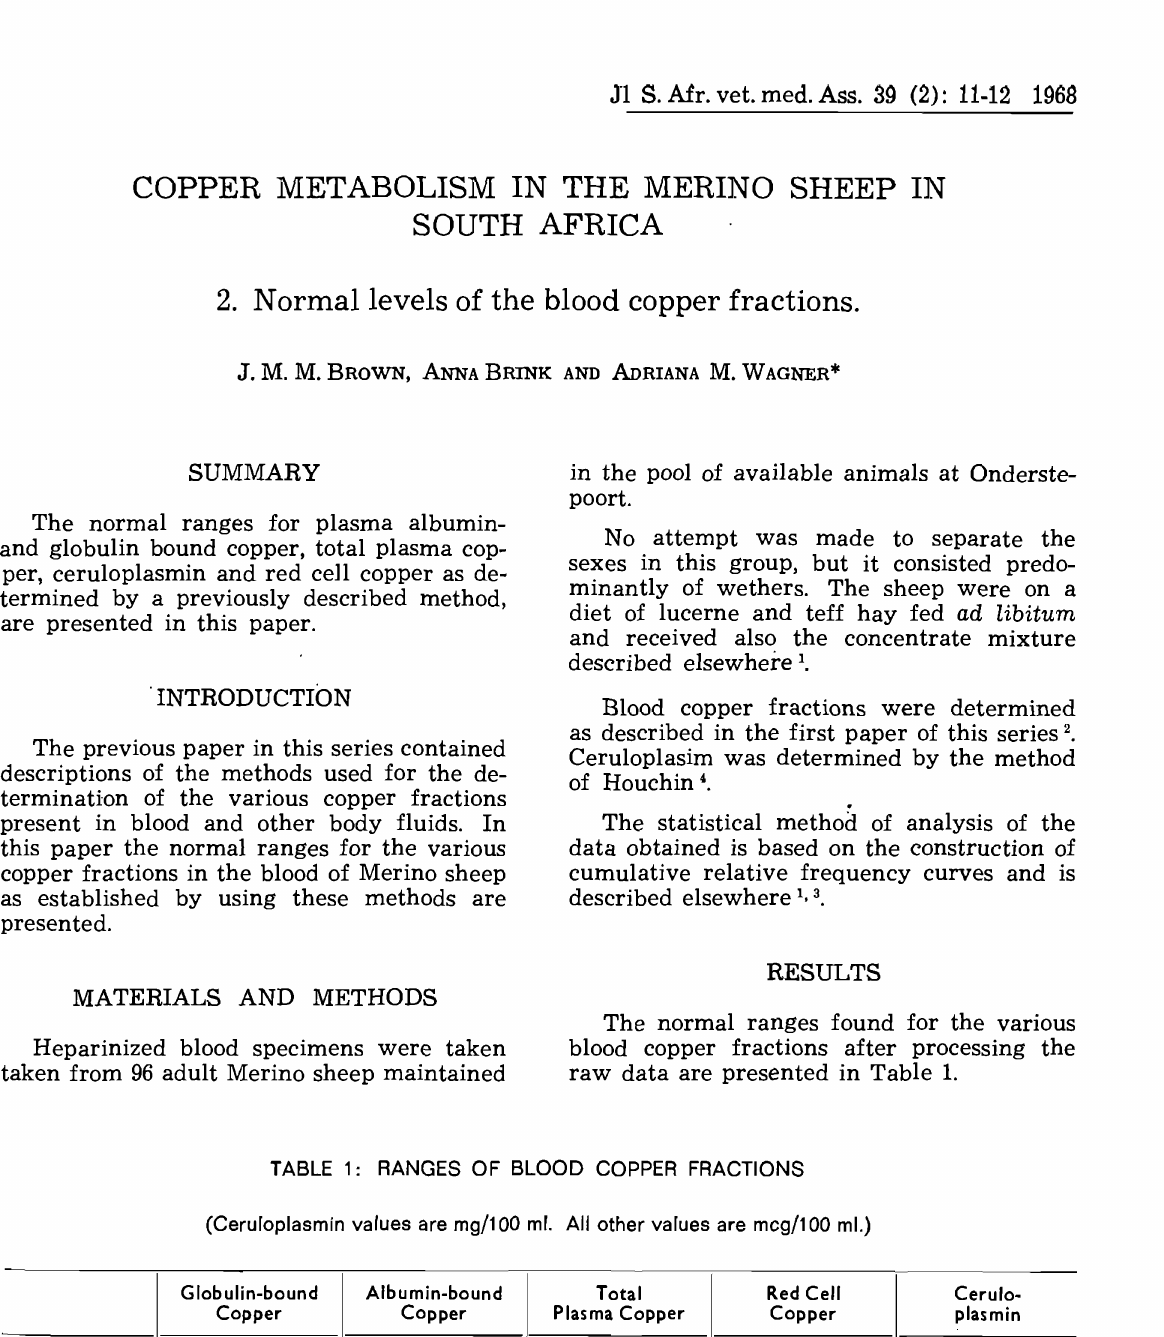
TABLE 1: RANGES OF BLOOD COPPER